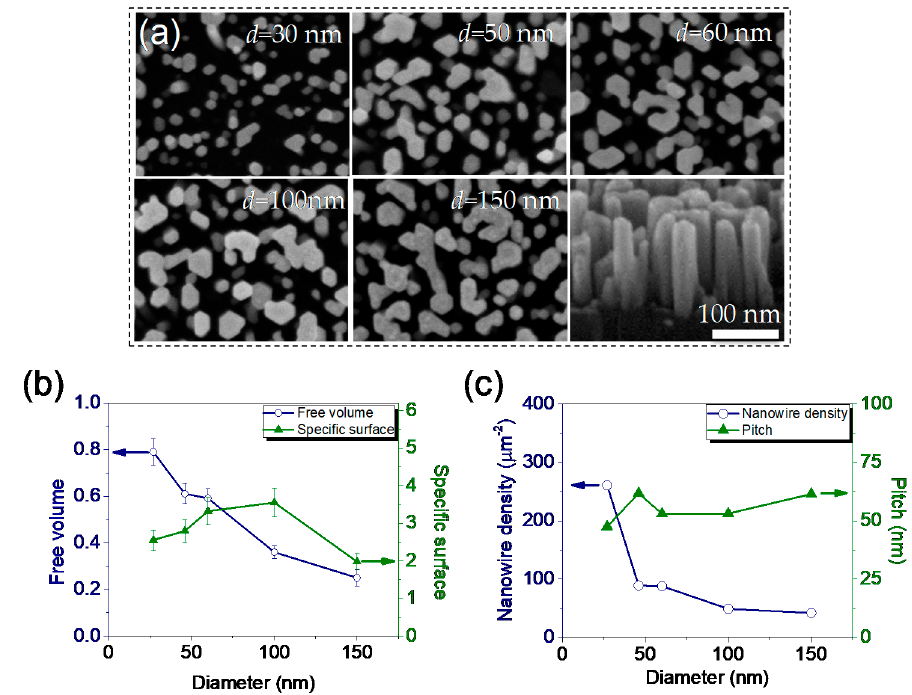
Figure 2. ( a ) Plan and bird’s eye view SEM images of GaN nanostructures with average diameters 30, 50, 60, 100 and 150 nm. Nanowire coalescence could be observed for d = 50 − 100 nm with a transition into nano-walls at d = 150 nm. Morphological features of GaN NWs: ( b ) Free volume (left axis, blue circles) and specific surface (right axis, green triangles) vs. average diameter; ( c ) Nanowire density per µ m 2 (left axis, blue circles) and pitch vs. average NW diameter (right axis, green triangles). Color online.